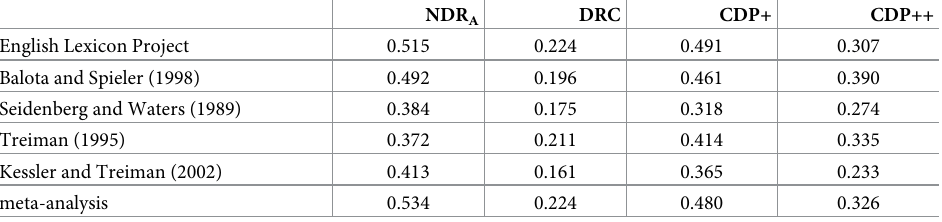
Table 3. Item-level correlations. Item-level correlations for the English Lexicon Project, Balota and Spieler (1998), Sei- denberg and Waters (1989), Treiman (1995), and Kessler and Treiman (2002) data sets, as well as for a meta-analysis of these data